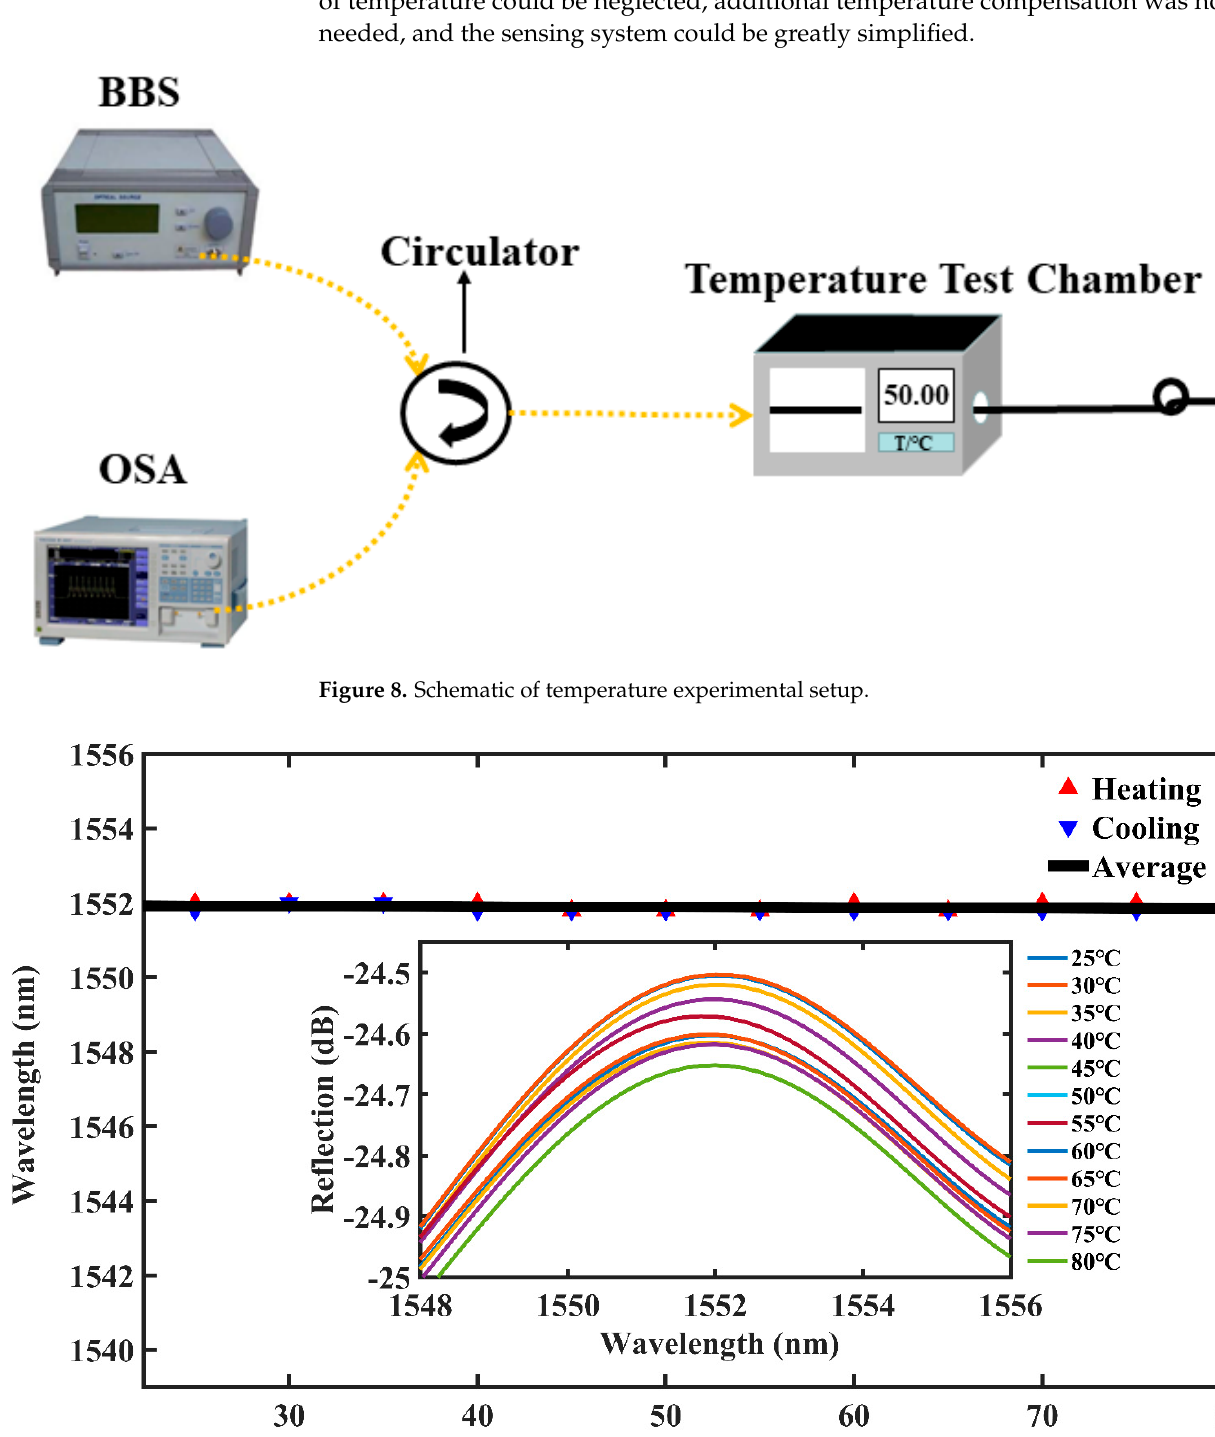
Table 1. Comparisons of the proposed sensors with other representative structures .